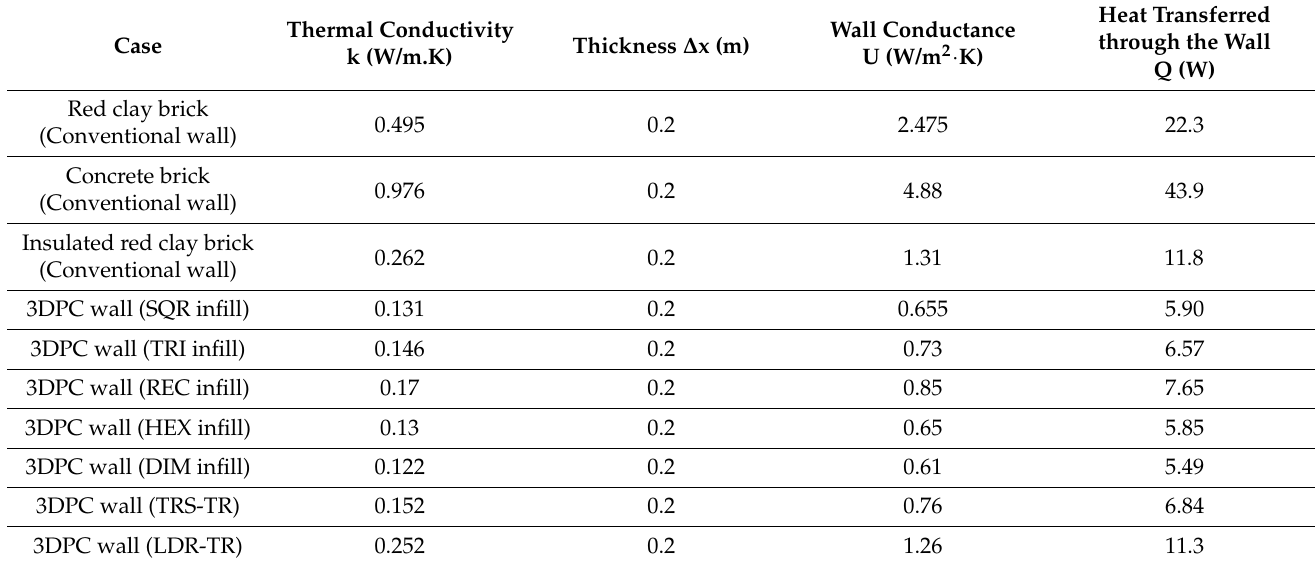
Table 4. Thermal characteristics of conventional and 3DPC walls.